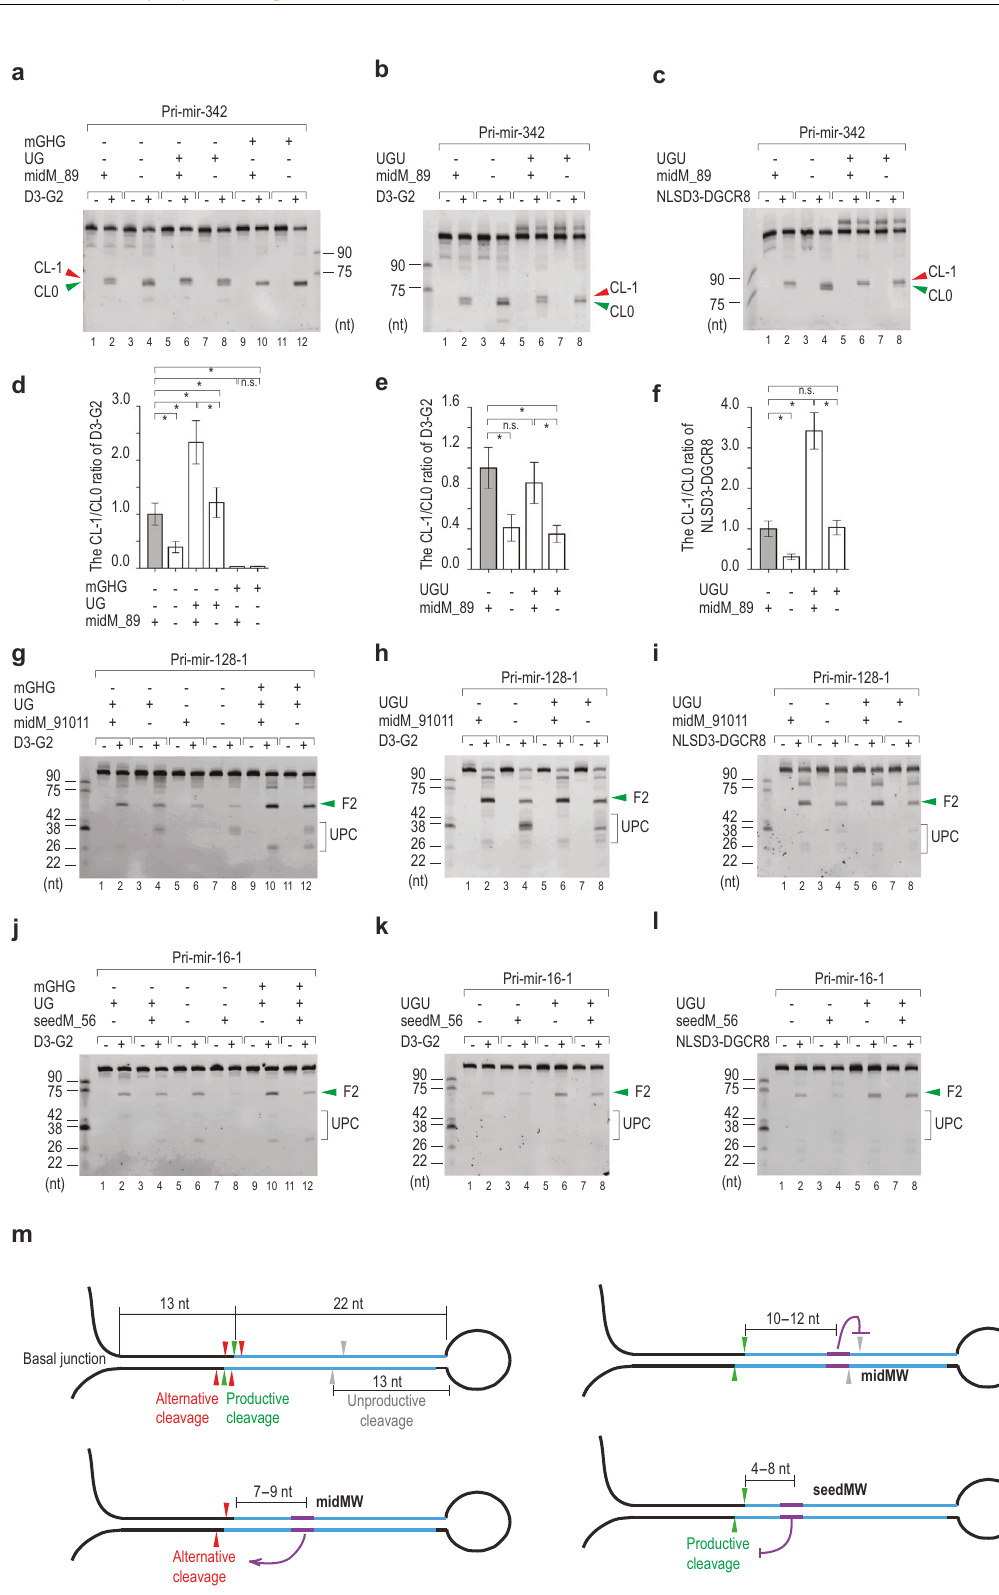
IVT reaction using the MEGAscript T7 transcription kit. The resulting RNAs were gel-puri fi ed and quanti fi